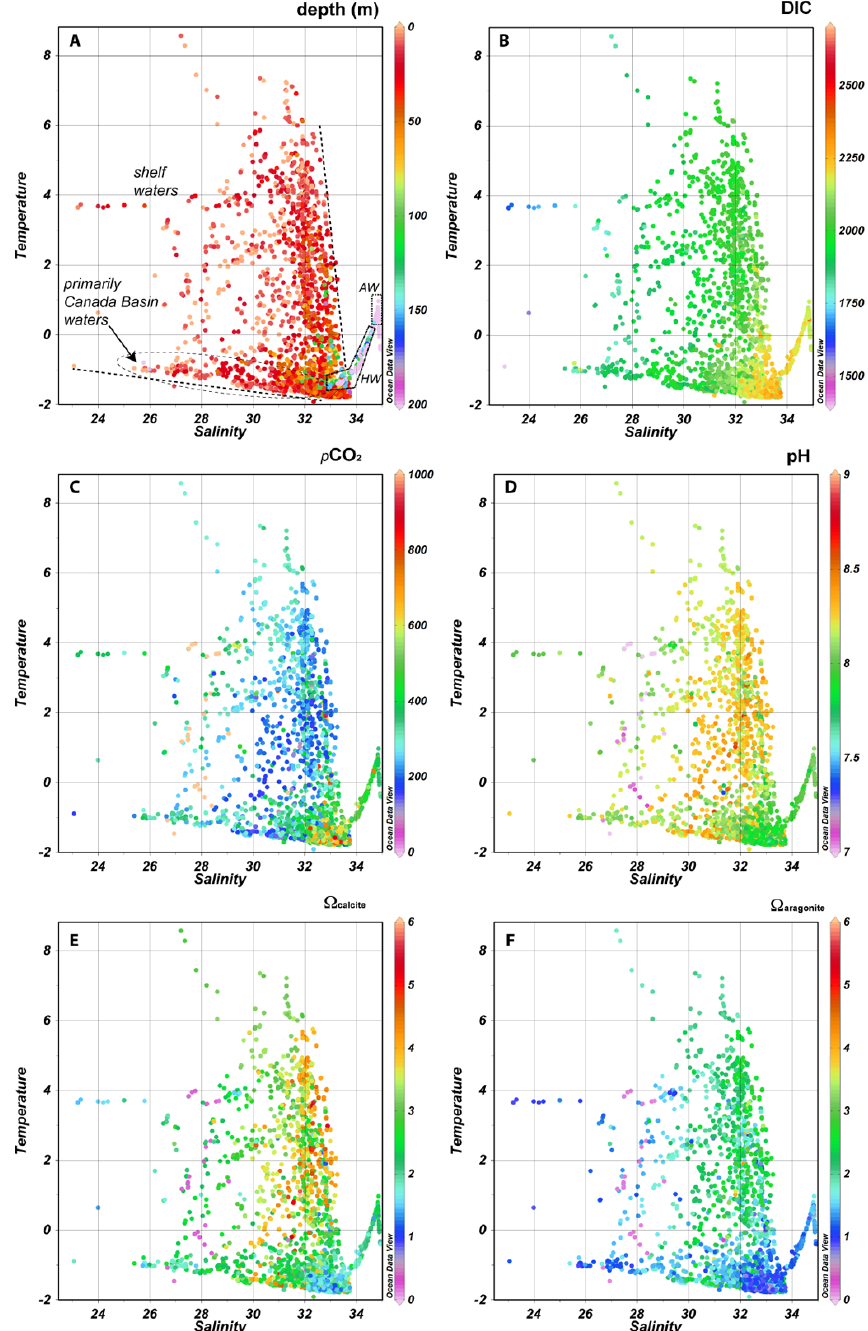
Fig. 2. Summertime scatter plots of depth and seawater CO 2 -carbonate chemistry superimposed on temperature versus salinity compiled for years 2009–2011 in the western Arctic Ocean. The panels include (A) depth (m) – samples within the bold dashed line represent shelf waters; samples from depths greater than 200m are denoted as a uniform color (purple) and represent offshelf samples in the Canada Basin including halocline waters (HW) and Atlantic water (AW; Bates et al., 2005a). The approximate distribution of Canada Basin waters are shown within the light dashed line; (B) dissolved inorganic carbon (DIC; µmolkg − 1 ) ; (C) p CO 2 (µatm); (D) pH; (E) (cid:127) calcite ; and ( F ) (cid:127) aragonite . The TS diagram shows the envelope of surface water in the western Arctic ( T : − 1.5 to 7.5 ◦ C; S : 24 to 33), while subsurface waters on the Chukchi Sea were more confined with regard to physical properties ( T : − 1.5 to + 1 ◦ C; S : 32–34). All panels also show the seawater CO 2 -carbonate chemistry properties of the Atlantic Water (AW; Emery, 2003) observed in the Canada Basin (temperature: 0.5 to 1 ◦ C; salinity: 34.7 to